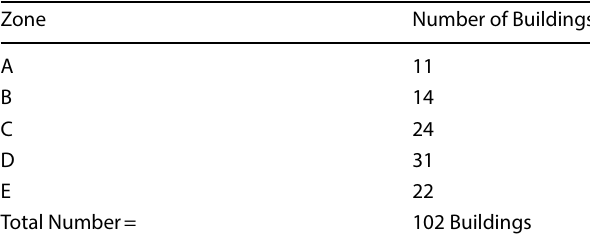
Table 3 Number of buildings assigned at each